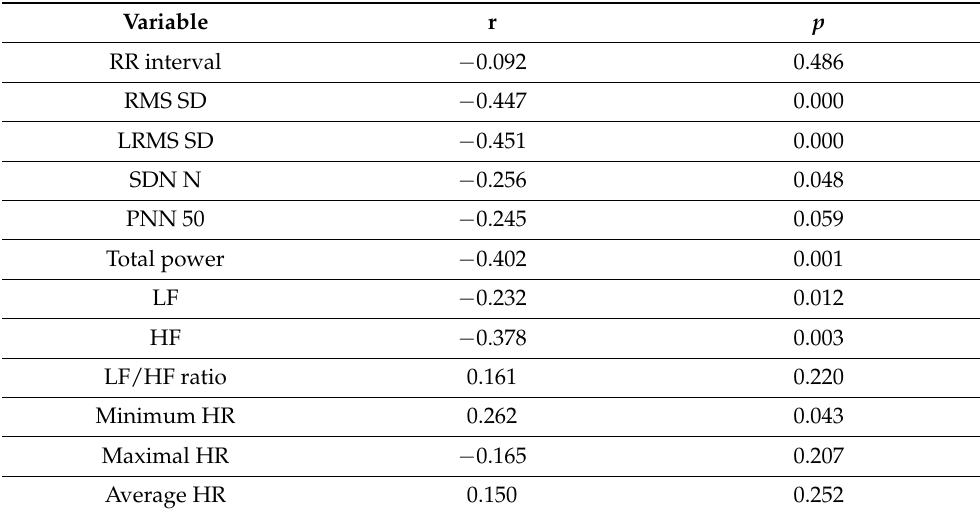
Table 2. Correlation analysis between visual analogue scale and heart rate variability